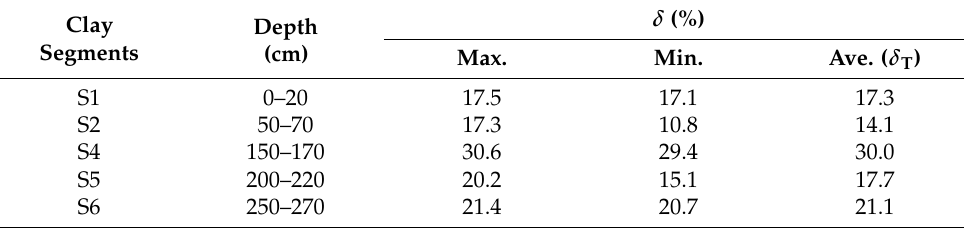
Table 3. Temperature effect on the undrained shear strength of deep ‐ sea sediment segments. Clay